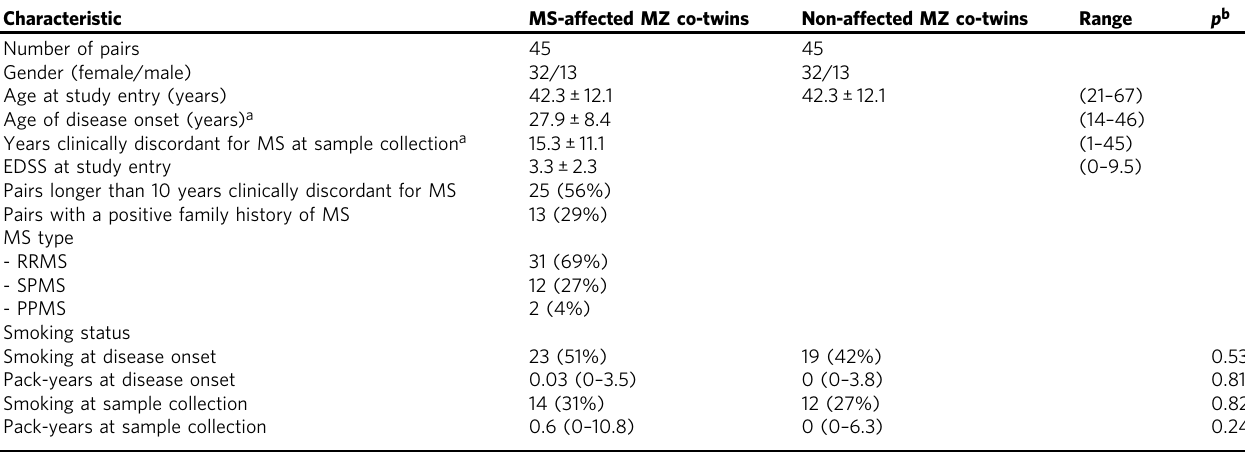
Table 1 Characteristics of the MZ twins clinically discordant for MS